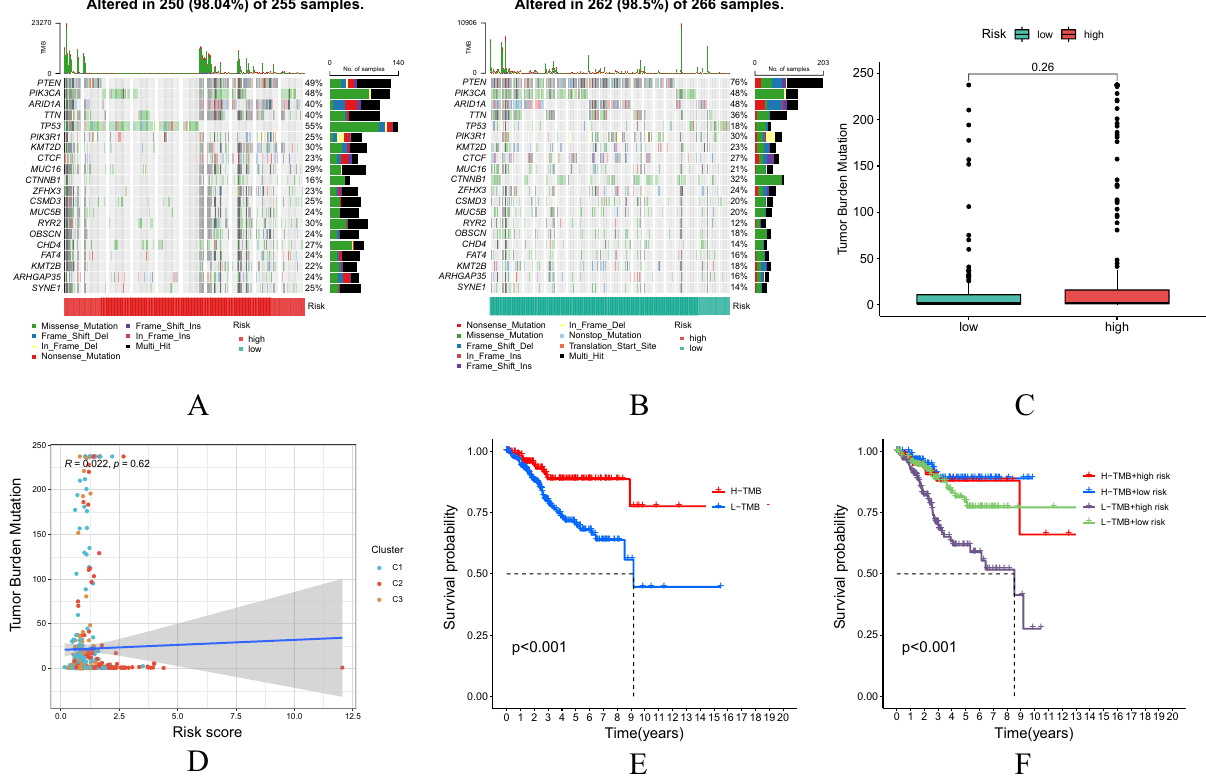
Figure 9. Correlation analysis of TMB levels between the two risk subgroups. ( A,B ) Distribution of the first 20 mutant genes in the high and low risk groups. ( C ) Difference analysis of TMB in the two risk subgroups. ( D ) Correlation between TMB and risk score. ( E,F ) Analysis of OS in UCEC patients in combination with TMB levels and risk